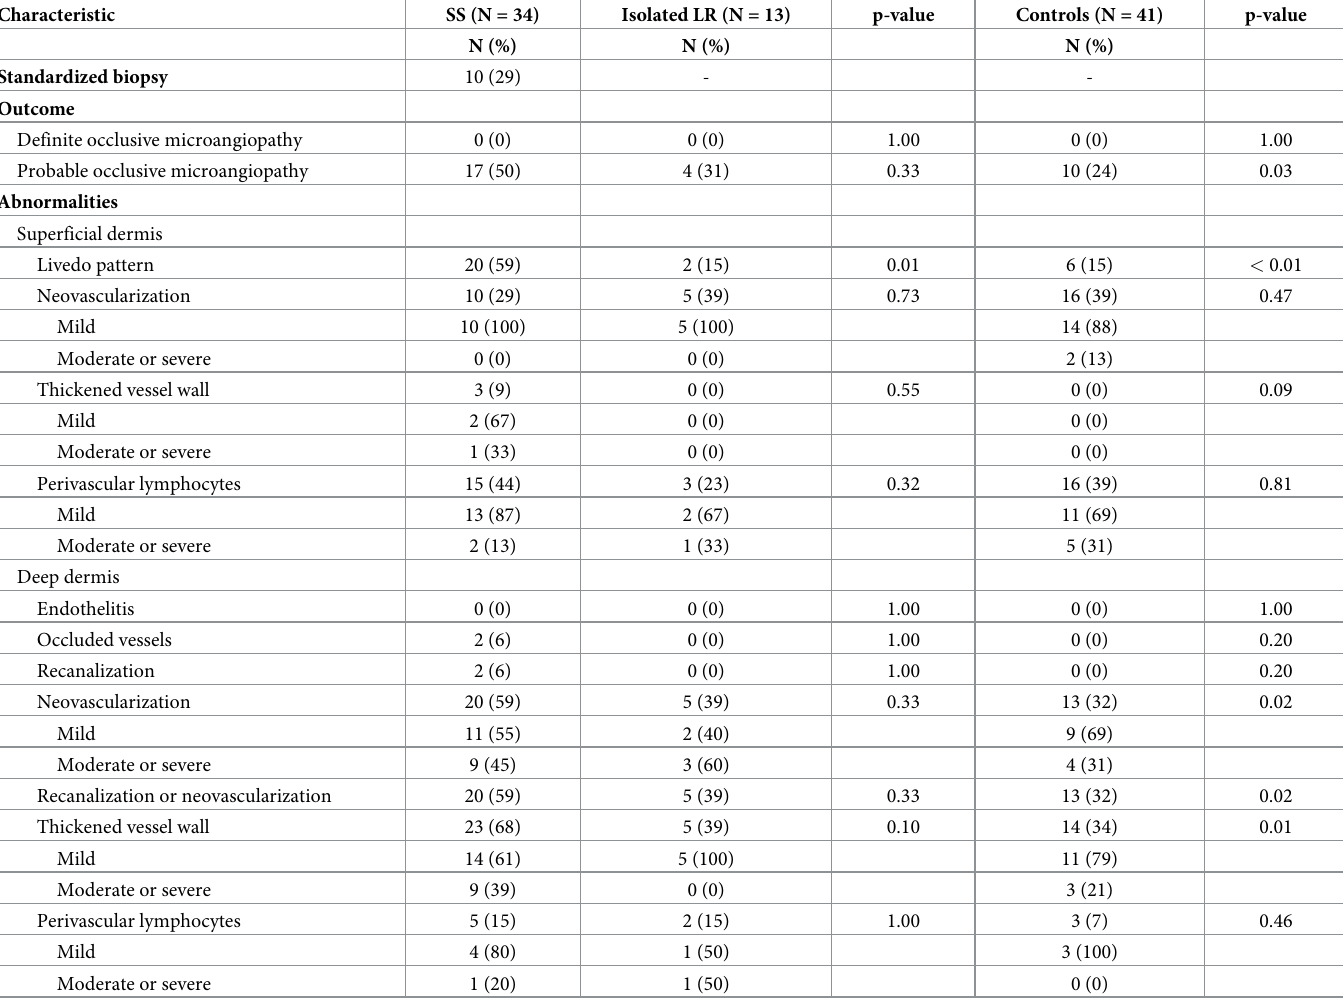
Table 2. Histology